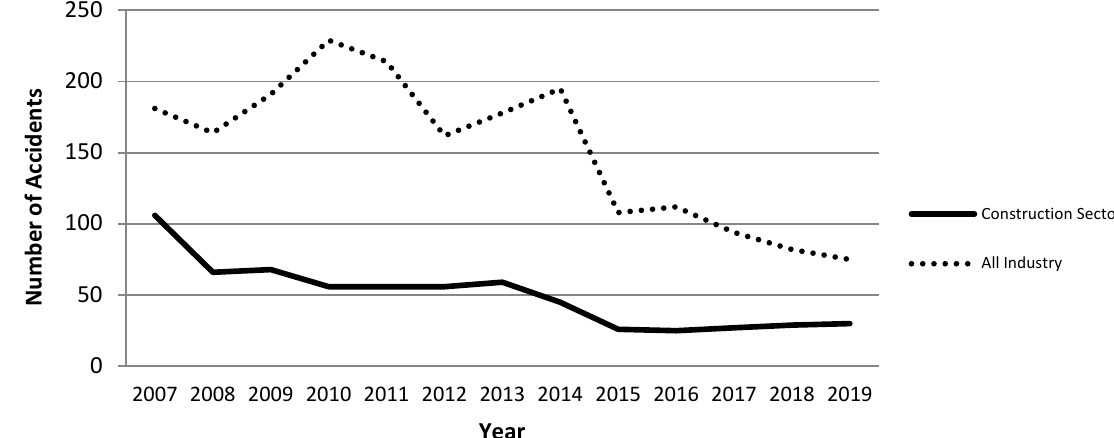
Figure 1. Number of accidents in both the construction sector and other industries from 2007 to 2019 (TRNC Ministry of Labour and Social Security,